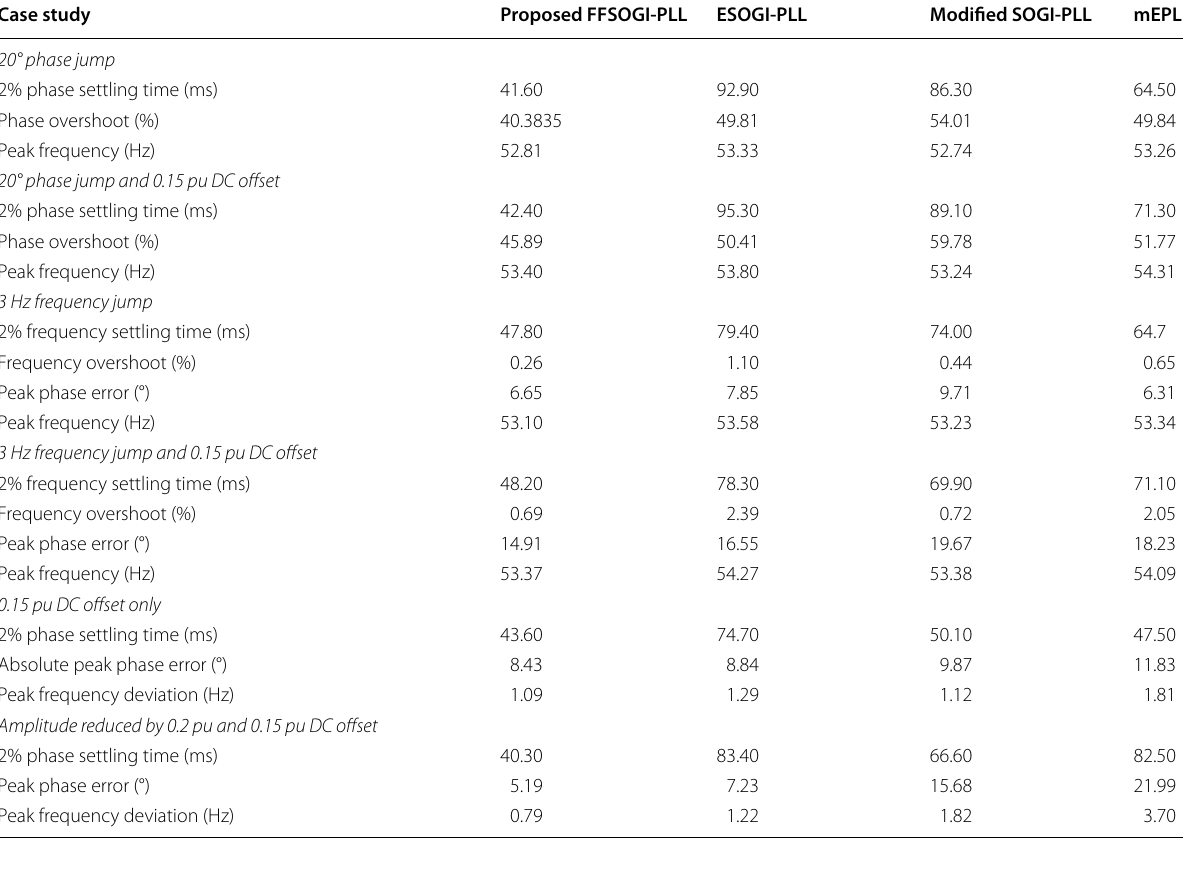
Table 1 Summarized results for the different PLLs and the proposed PLL